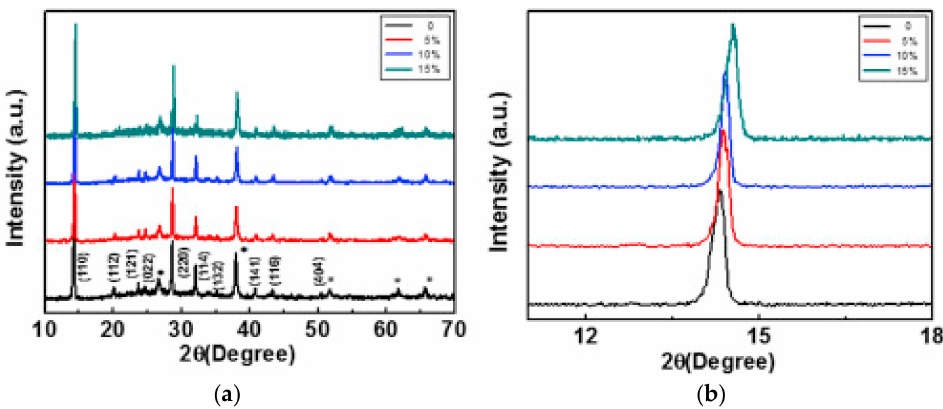
Figure 6. XRD spectrum of MA(Pb:Zn)I 3 -based thin films after incorporation of Zn 2 + in concentrations of 0, 5, 10 and 15% ( a ). A shift of the peak representing the 110 plane is clearly visible in ( b ). Figure reprinted with permission from Mater. Today Energy 2017 , 5 , 205–213, Reference